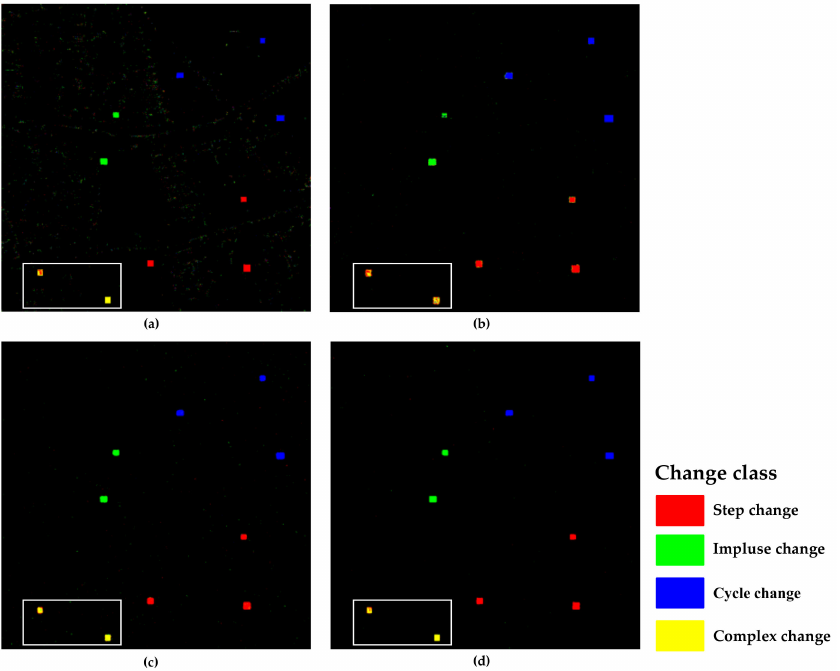
Figure 6. The time-series change detection and classification results of synthetic case: ( a ) normalized cut on change criterion matrix (NORCAMA); ( b ) NOR_KLD; ( c ) NOR_KS2; ( d ) Proposed method.